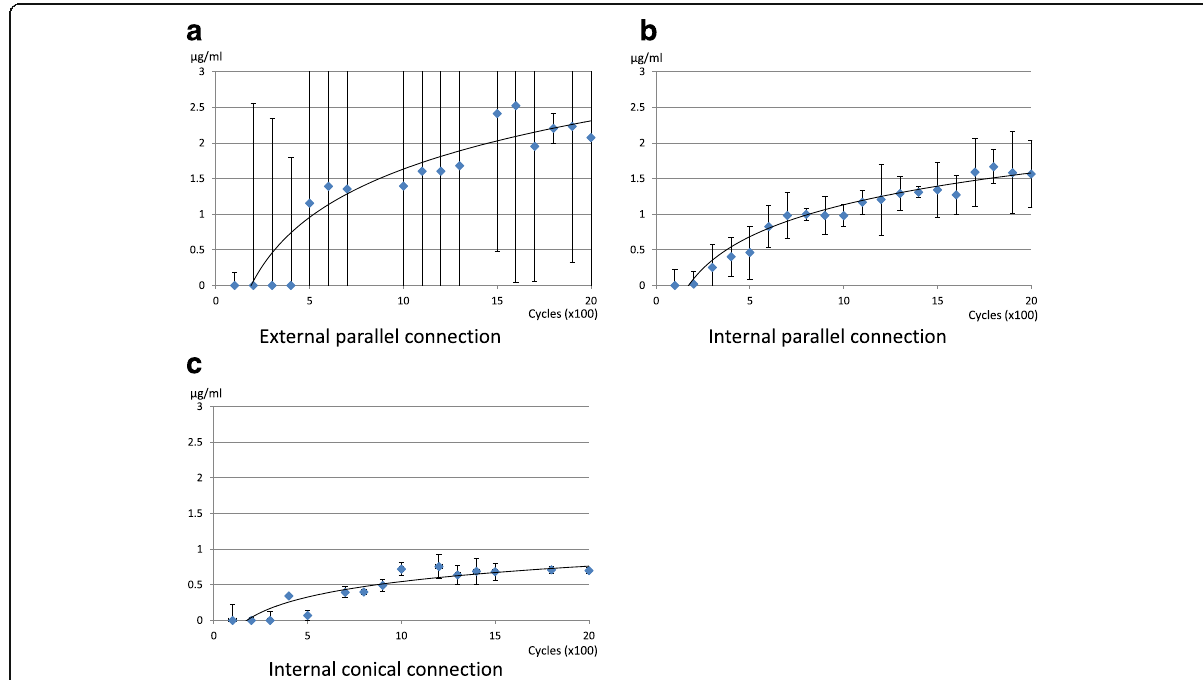
Fig. 3 a Microleakage from external parallel connection implant – abutment connection. Vertical bars indicate standard deviation. b Microleakage from internal parallel connection implant – abutment connection. Vertical bars indicate standard deviation. c Microleakage from internal conical connection implant – abutment connection. Vertical bars indicate standard